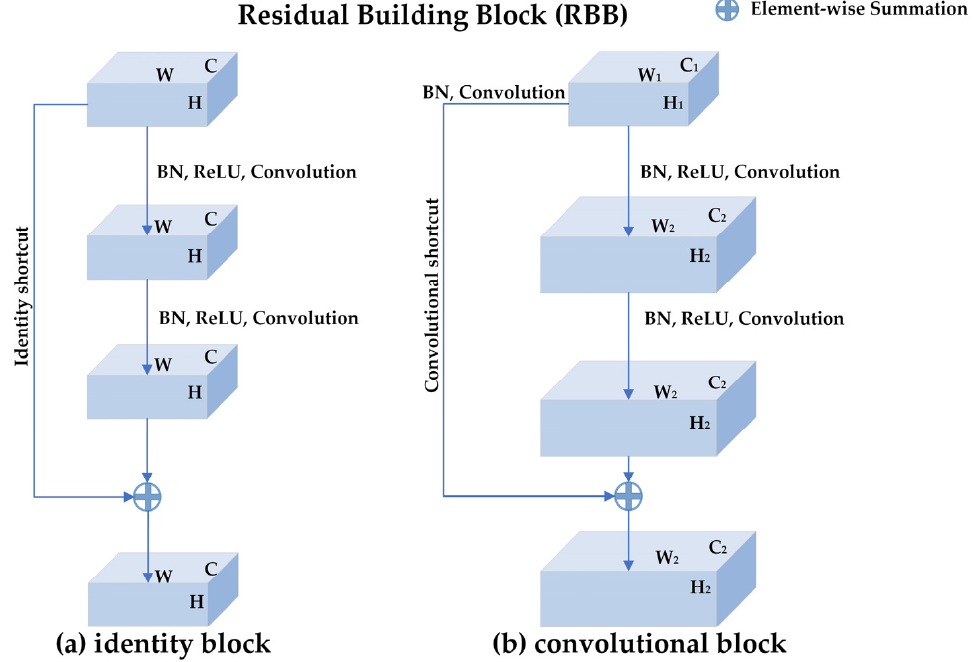
Figure 3. The structure of residual building block (RBB): ( a ) the identity block where the input feature map is the same size as the output feature map. H, W, and C represent the height, width, and channels of the input and output feature map, respectively. ( b ) the convolutional block where the size of the input feature map is different from that of the output feature map. There is a convolution operation and a Batch-normalization operation in the convolutional shortcut for changing the shape of the input. H 1 , W 1 , and C 1 represent the height, width, and channels of the input feature map, respectively. H 2 , W 2 , and C 2 represent the height, width, and channels of the output feature map, respectively. An RBB consists of two convolutional layers, two batch normalization (BN) layers, two rectifier linear units (ReLUs) layers, and one shortcut connection.